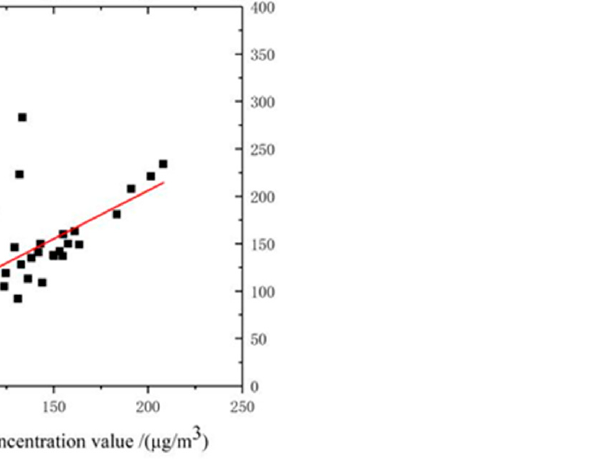
Figure 13. Scatter plot of PM 2.5 concentration at 2:00 (UTC) and the daily average. Fitted line is in red.